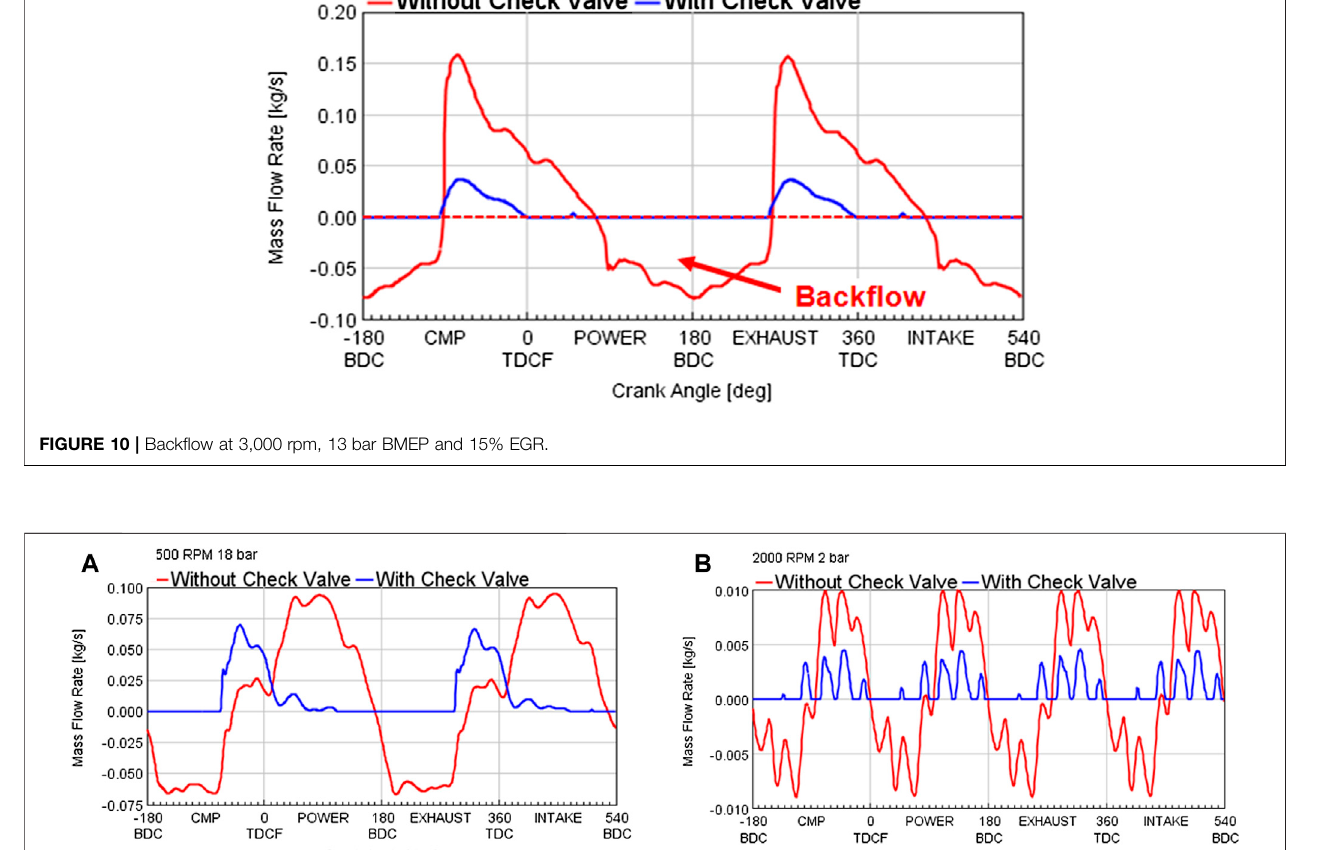
Frontiers in Mechanical Engineering |